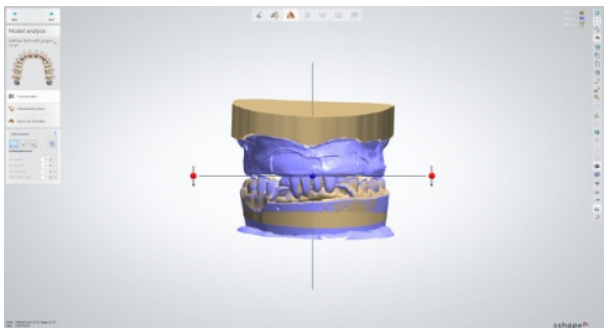
Figure 7. Determination of the occlusal plane in Dental System 2019 (3Shape™ A/S, Copenhagen, Denmark) software.